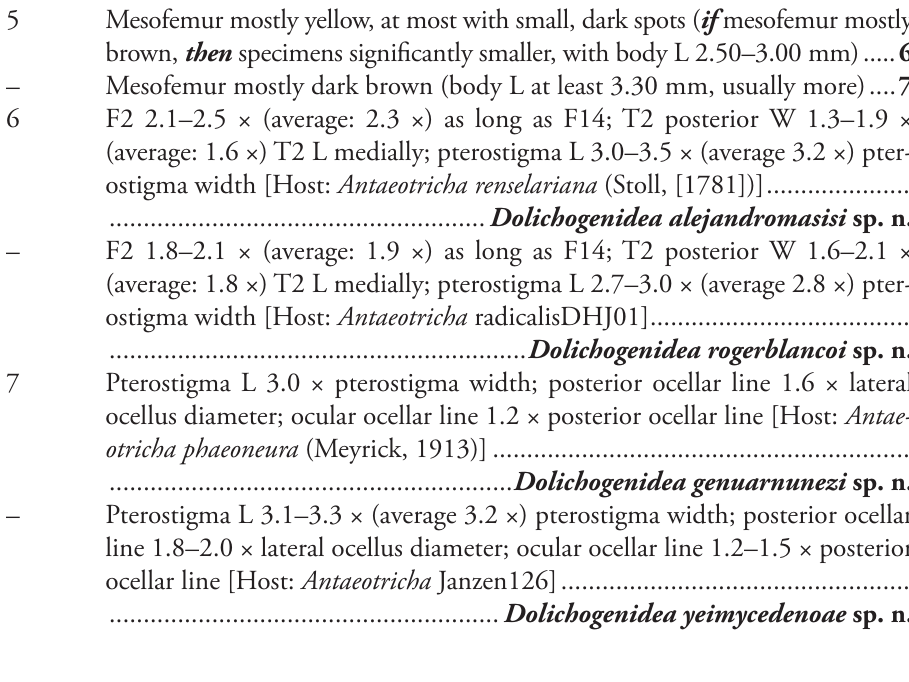
Taxonomic treatment of species, in alphabetical order Dolichogenidea alejandromasisi Fernandez-Triana & Boudreault, sp. n.